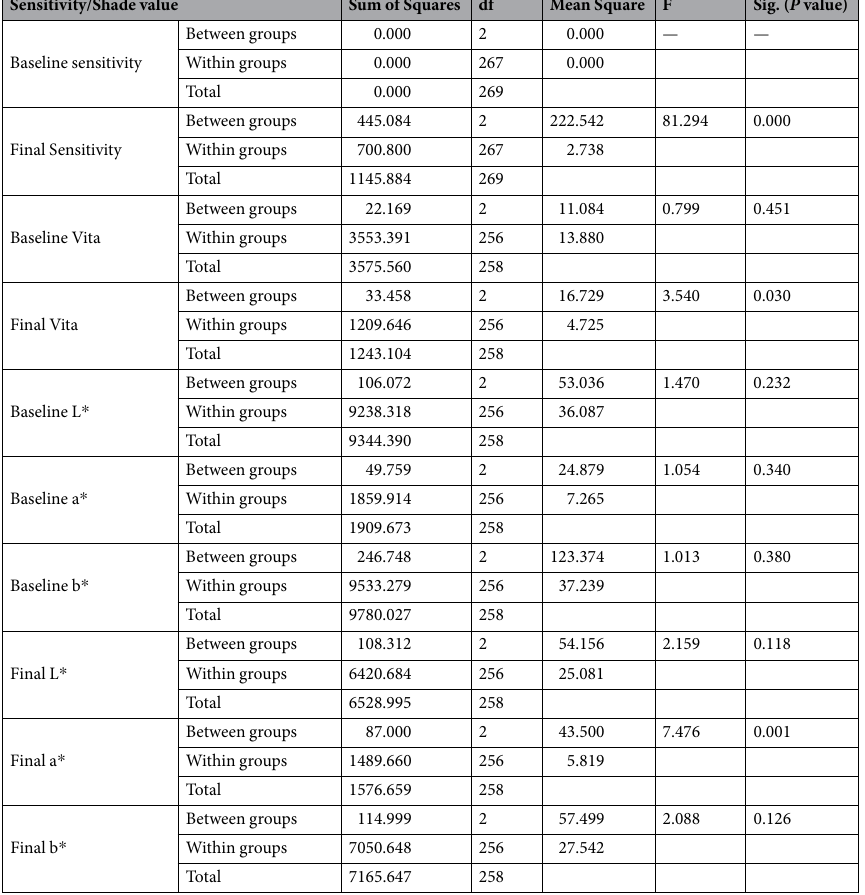
Table 3. Analysis of variance (ANOVA) of shade values between groups at baseline and after bleaching (n = 90 tooth surfaces in 15 participants for each group). df = Degree of Freedom; Sig. = Significance; F = F